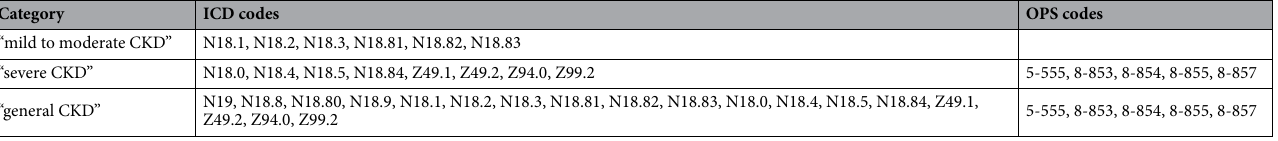
Table 1. Outcome variables. Change of ICD code N18.- in 2010; both versions of ICD coding for CKD (before and after 2010) were used for the